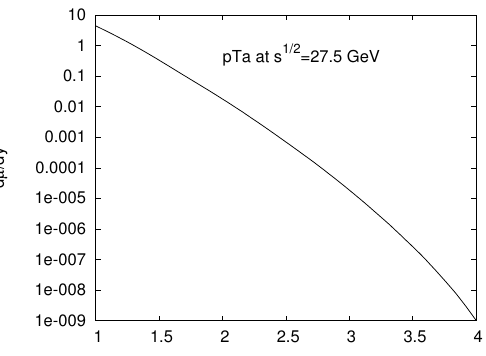
Figure 6. Multiplicities per unit rapidity for production of cumulative pions at cumulativity x ≥ 1 in p-Ta collisions at 27.5